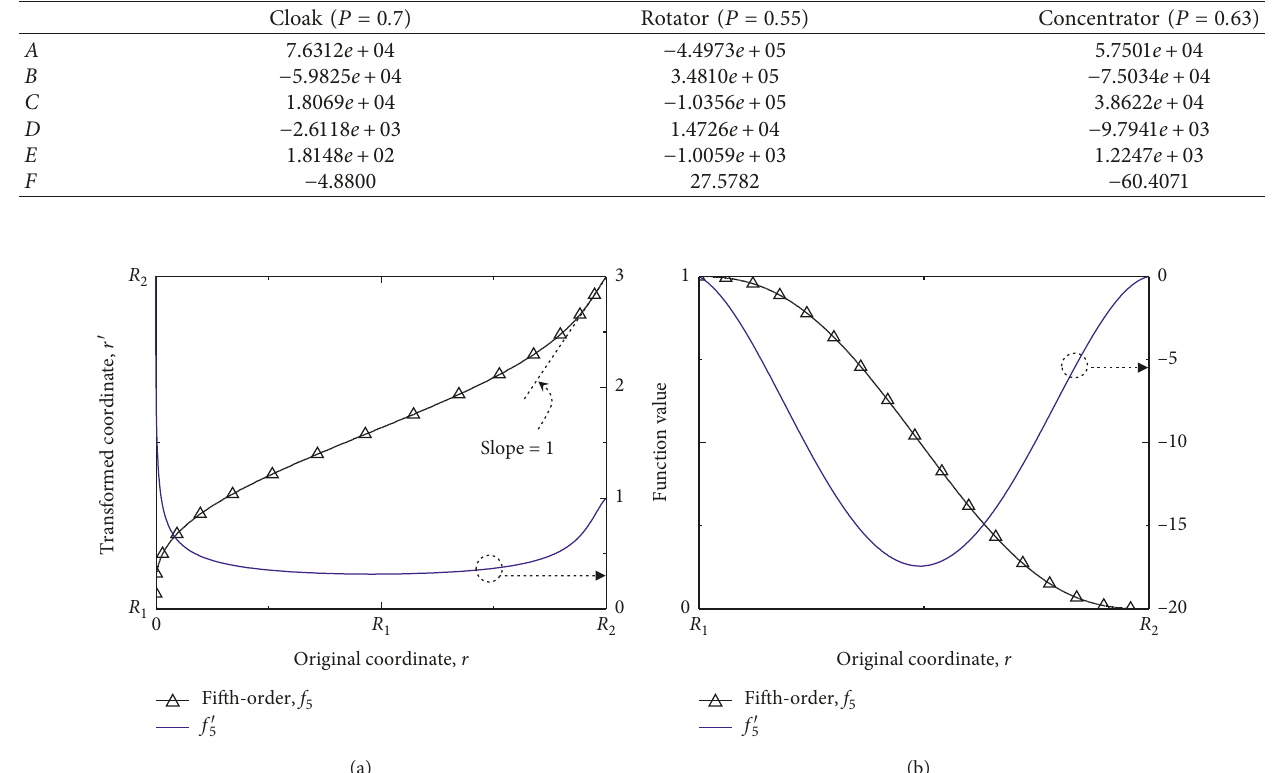
Table 2: Coefficients of fifth-order polynomial functions.